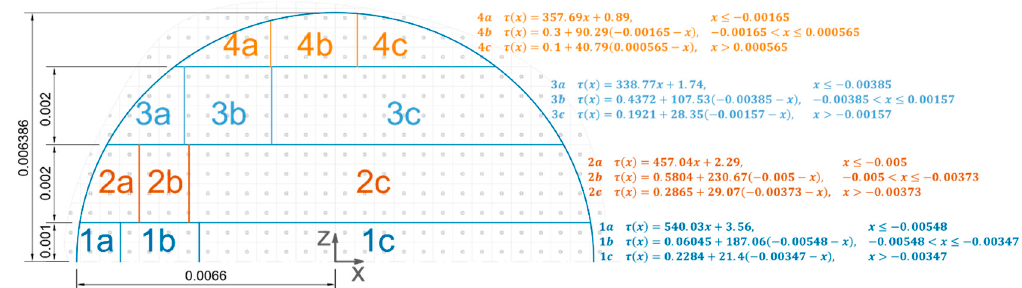
Figure 8. Half of the load area divided into four parts with a tri-linear function for each part. Functions describe the shear traction stress values in the load area. The other half of the load area is a mirror image. The axis directions and node size are the same as in the rail head’s model.